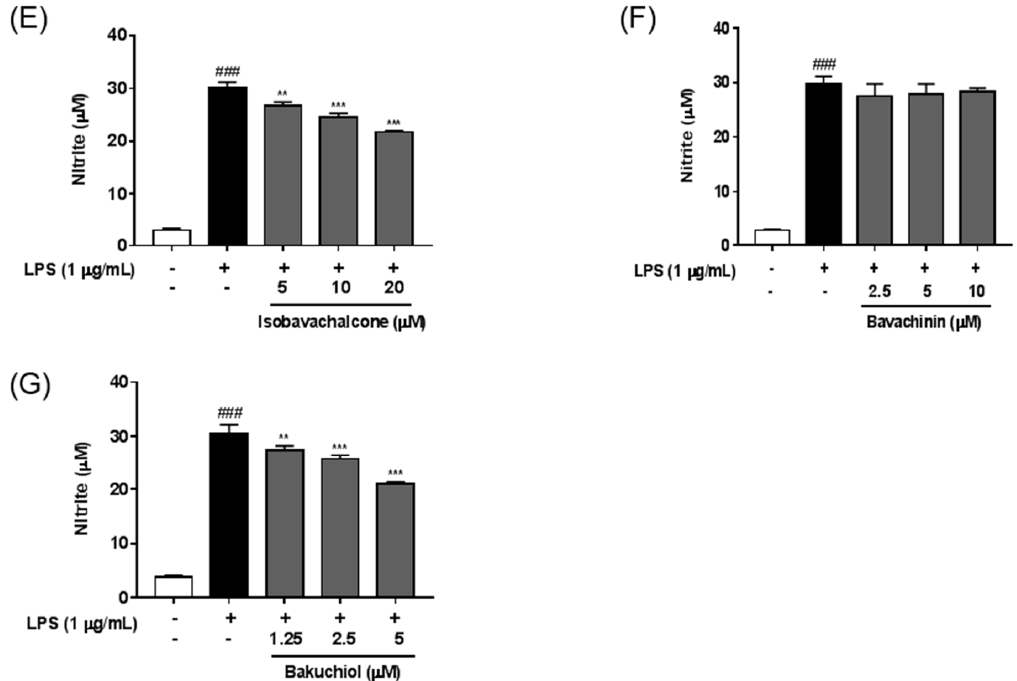
Figure 3. Anti-neuroinflammatory effects of the seven components from P. corylifolia in LPS-stimulated